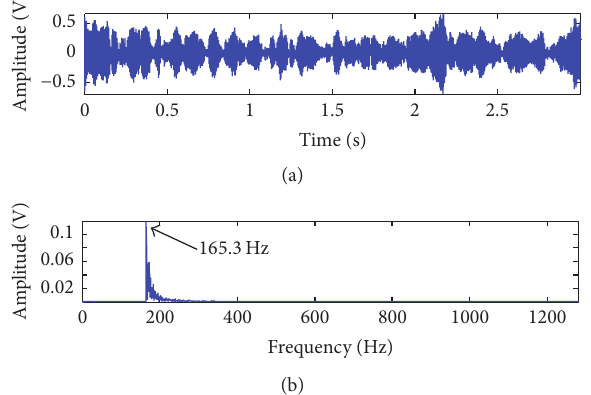
Figure 17: The enhanced result of IMF2 with an inner fault via adaptive stochastic resonance: (a) time-domain waveform; (b) frequency